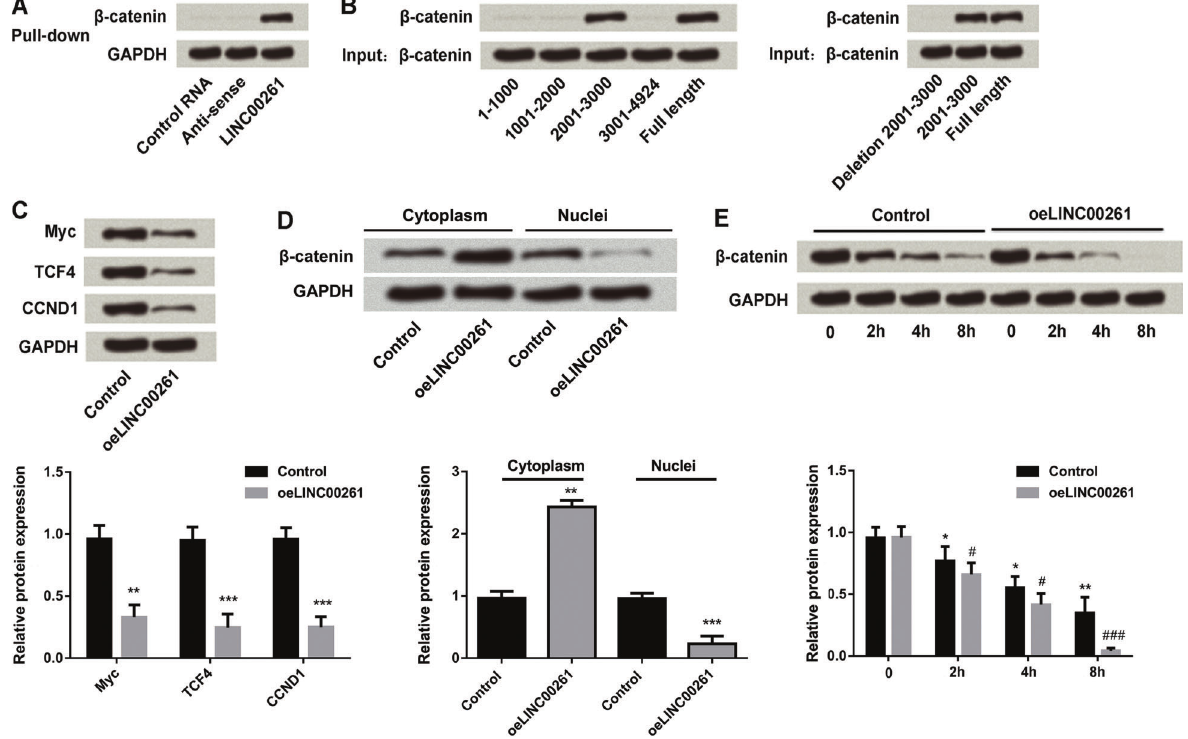
Figure 6. Effects of LINC00261 on Wnt/ b -catenin pathway. A , Effect of LINC00261 on b -catenin and B , nt:2001-3000 segment of lncRNA interaction with b -catenin. C , oeLINC00261 inhibited Wnt pathway activation likely decreasing expression of target genes Myc, TCF4, and CCND1. D , LINC00261 overexpression suppressed intranuclear b -catenin. E , LINC00261 overexpression promoted the degradation of b -catenin with extending time. Oe: overexpression. Data are reported as means ± SD. *P o 0.05, **P o 0.01, ***P o 0.001 compared to control (0 h); # P o 0.05, ### P o 0.001 compared to oeLINC00261 (0 h)